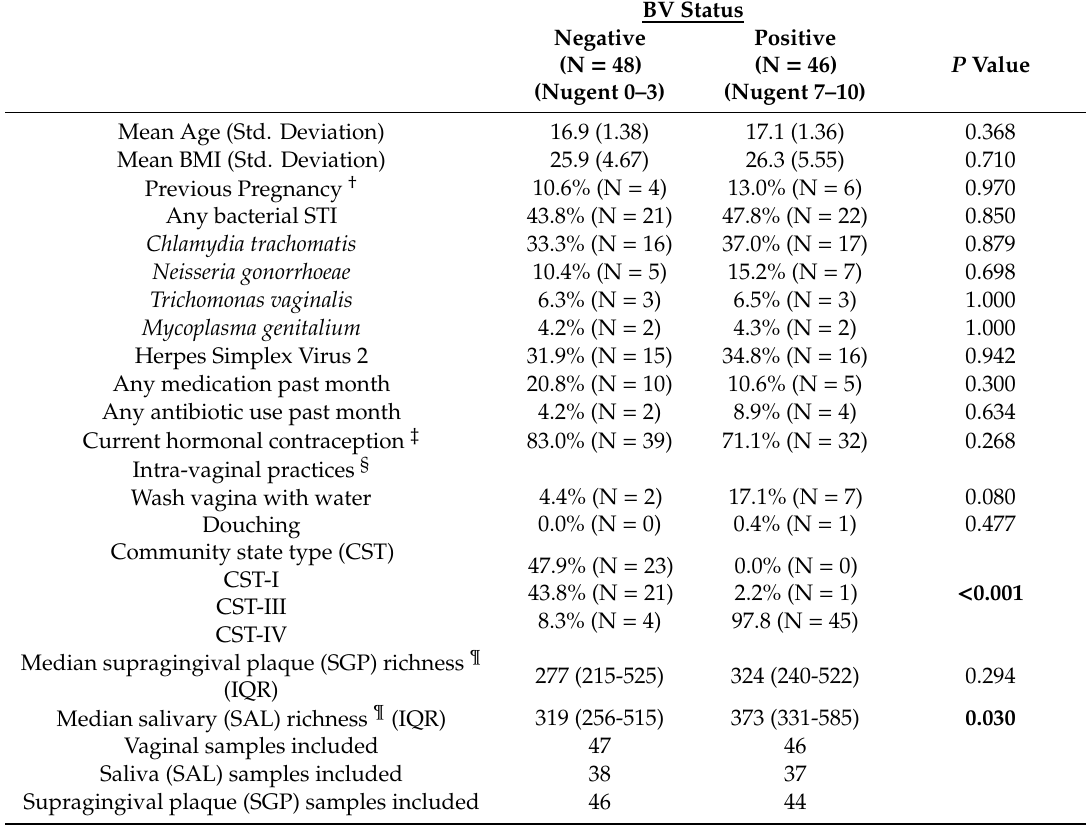
Table 1. Cohort characteristics by bacterial vaginosis (BV)